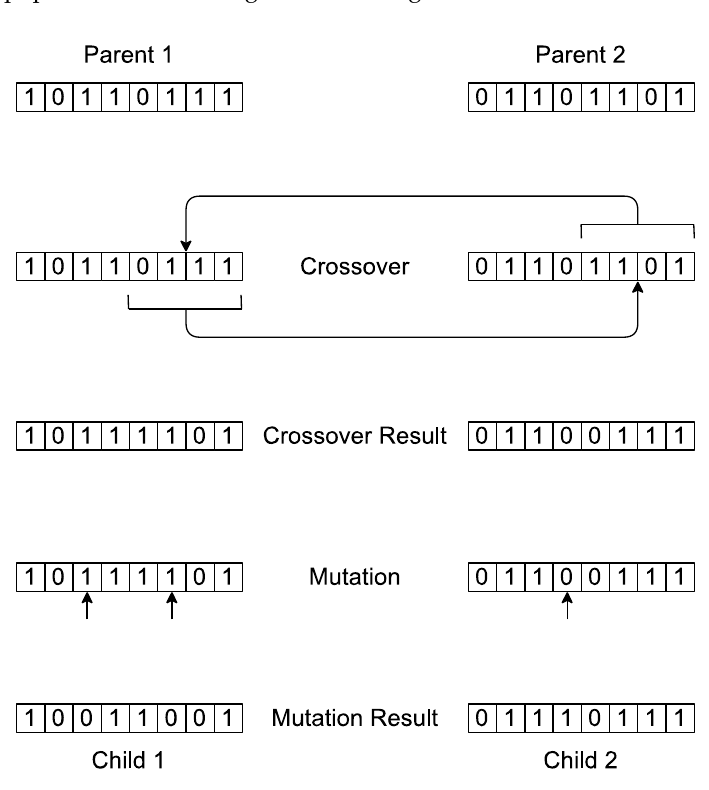
Figure A2. Crossover and mutation operation of genetic algorithm.